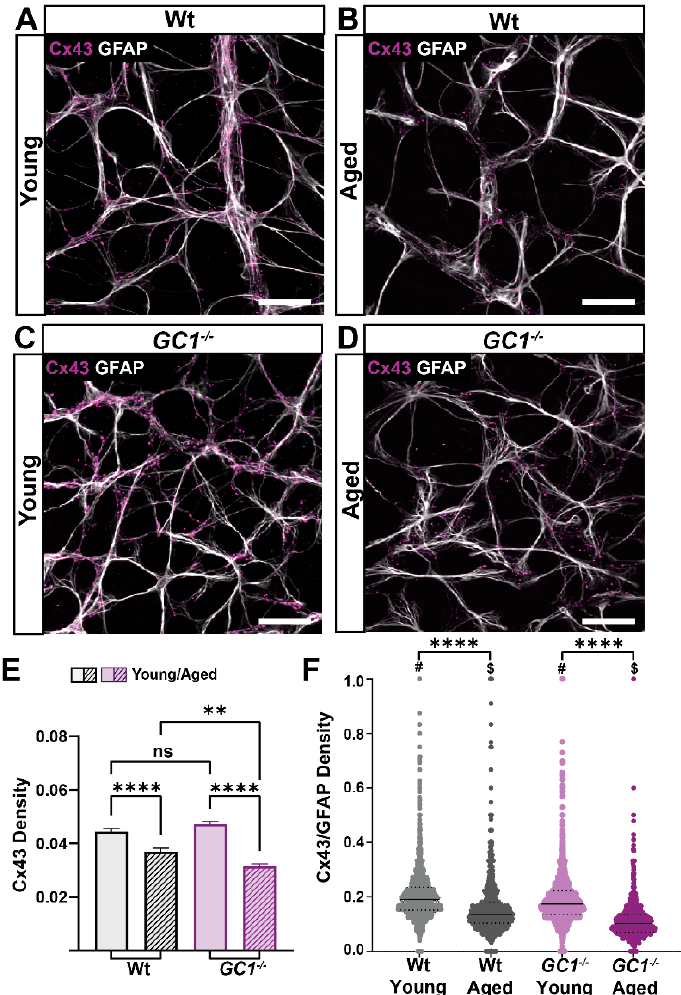
Figure 6. Connexin 43 (Cx43) density decreases significantly with age in Wt and GC1 − / − mice. ( A ) Representative confocal micrographs of astrocytes (GFAP; white) and Cx43 (magenta) in retina of young Wt mice. ( B ) Representative confocal micrographs of astrocytes (GFAP; white) and Cx43 (magenta) in retina of aged Wt mice. ( C ) Representative confocal micrographs of astrocytes (GFAP; white) and Cx43 (magenta) in retina of young GC1 − / − mice. ( D ) Representative confocal micrographs of astrocytes (GFAP; white) and Cx43 (magenta) in retina of aged GC1 − / − mice. Scale bar = 40 µm. ( E ) Cx43 density across entire retinae of young and aged Wt and GC1 − / − mice. Cx43 significantly de- creases with age in Wt mice ( n = 8 Wt, n = 10 GC1 − / − ;**** p < 0.0001) and significantly decreases with age in GC1 − / − mice ( n = 3 Wt, n = 4 GC1 − / − ; **** p < 0.0001). There is a significant difference between aged Wt and GC1 − / − mice ( n = 8 Wt and n = 4 GC1 − / − ; ** p = 0.005) ( F ) The ratio of Cx43 to GFAP density for each quadrant analyzed shows a significant difference between young and aged Wt mice (**** p < 0.0001) and young and aged GC1 − / − mice (**** p < 0.0001). There is also a significant difference between genotypes in young (# p < 0.0001) and aged ($ < 0.0001) mice. All data expressed as means ± S.E.M. Statistical analyses carried out were Kruskall–Wallis one-way ANOVA. 2.6. Visual Acuity is Decreased with Age in GC1 − / − Mice It is well documented that GC1 − / − mice lose retinal ganglion cells with age [3,8], and that increasing the bioavailability of cGMP prevents degeneration [8]. Since our GC1 − / − mouse is not a conditional knockout and GC1 is implicated in photoreceptor physiology, we assessed whether changes in visual acuity were evident in young and aged animals (Figure 7). No visual acuity deficits were evident in young animals between genotypes. Although Wt visual acuity was non-significantly reduced, GC1 − / − mice had significantly reduced visual acuity at 15 months of age compared to Wt mice and younger GC1 − / − mice (Figure 7). These data support previous findings of thinning of the nerve fiber layer and RGC loss with age in GC1 − / − mice [ 3,8].